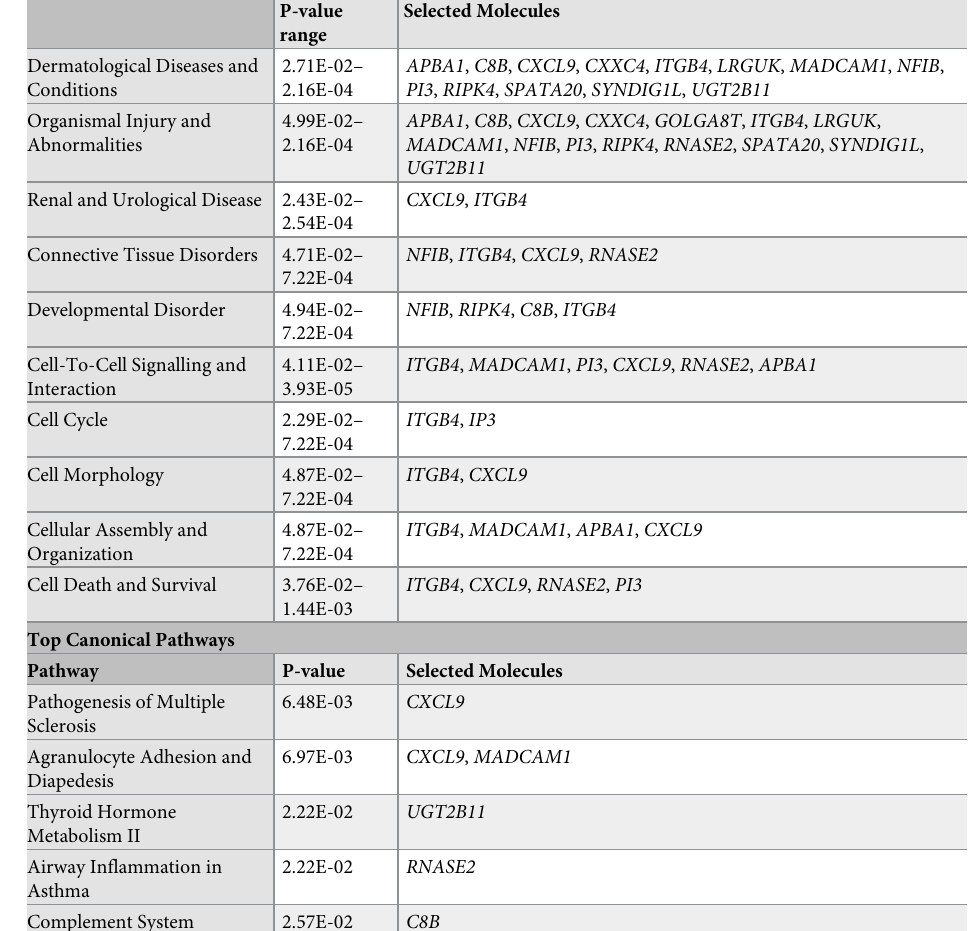
Table 14. Enrichment analysis of genes associated with COVID-19 severity (patients with COVID-19). Top Diseases and Biological